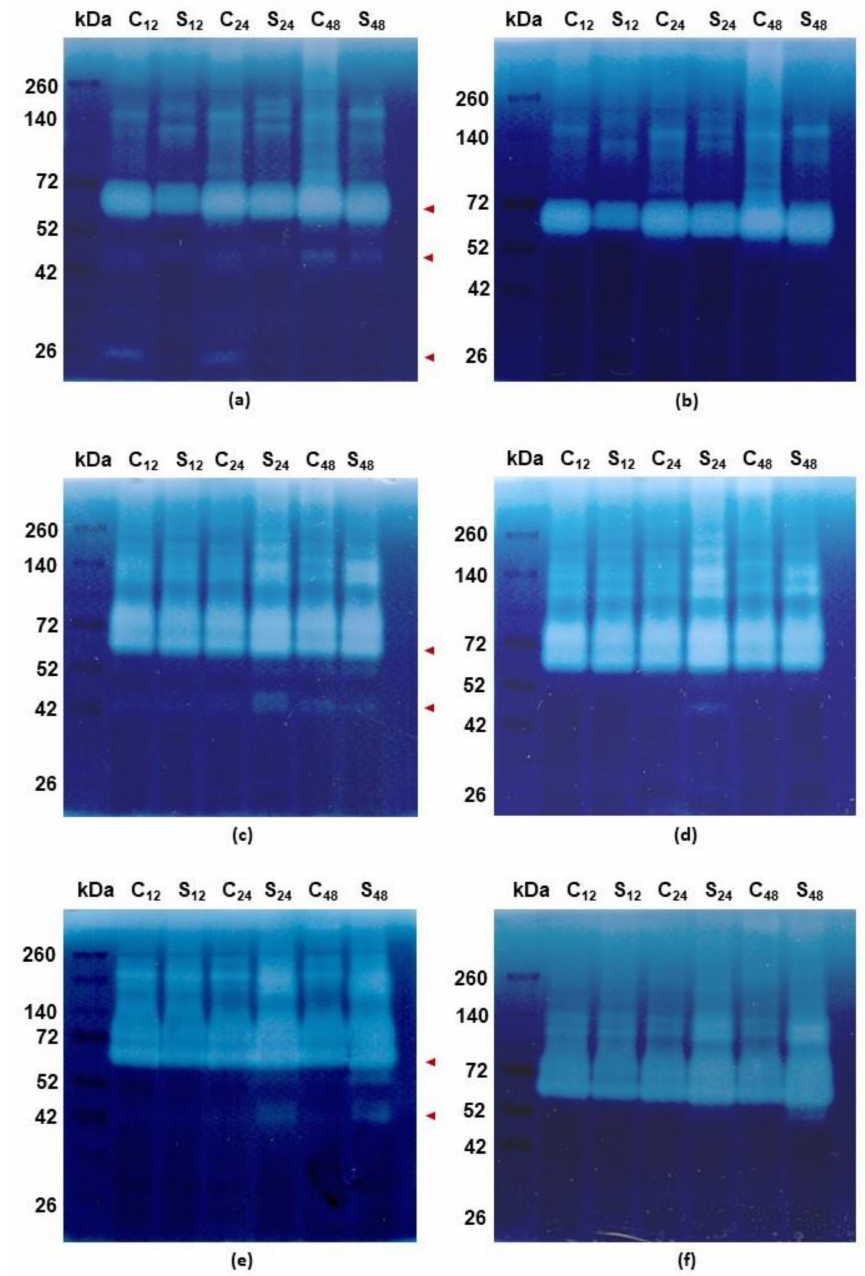
Figure 4. Representative results of the zymographic detection of gelatinolytic activity in roots of cereals at 12, 24 and 48 h after treatment with Al 3+ (0.59 mM) (S) and in untreated plants (C). Proteins (60 µ g) were electrophoresed with sodium dodecyl sulphate–polyacrylamide gel electrophoresis with gelatin as a substrate. Bands of the gelatinolytic activity were visualized by Amido Black. Spectra™ Multicolor Broad Range Protein Ladder was used to determine the protein molecular weight in kilodalton (kDa). ( a ) Electrophoresed tolerant rye cv. “Da´nkowskie Złote” protein root samples incubated at pH 5.2 without inhibitor for cysteine endopeptidases 10 µ ML-trans-epoxysuccinyl-leucylamido(4-guanidino)butane (E-64); ( b ) Electrophoresed tolerant rye cv. “Da´nkowskie Złote” protein root samples incubated at pH 5.2 with E-64; ( c ) Elec- trophoresed tolerant triticale cv. “KWS Trisol” protein root samples incubated at pH 5.2 without E-64; ( d ) Electrophoresed tolerant triticale cv. “KWS Trisol” protein root samples incubated at pH 5.2 with E-64; ( e ) Electrophoresed sensitive triticale cv. “Subito” protein root samples incubated at pH 5.2 without E-64; ( f ) Electrophoresed sensitive triticale cv. “Subito” protein root samples incubated at pH 5.2 with E-64. The red arrowheads show the bands that pay special attention (for more details including densitometric analysis see